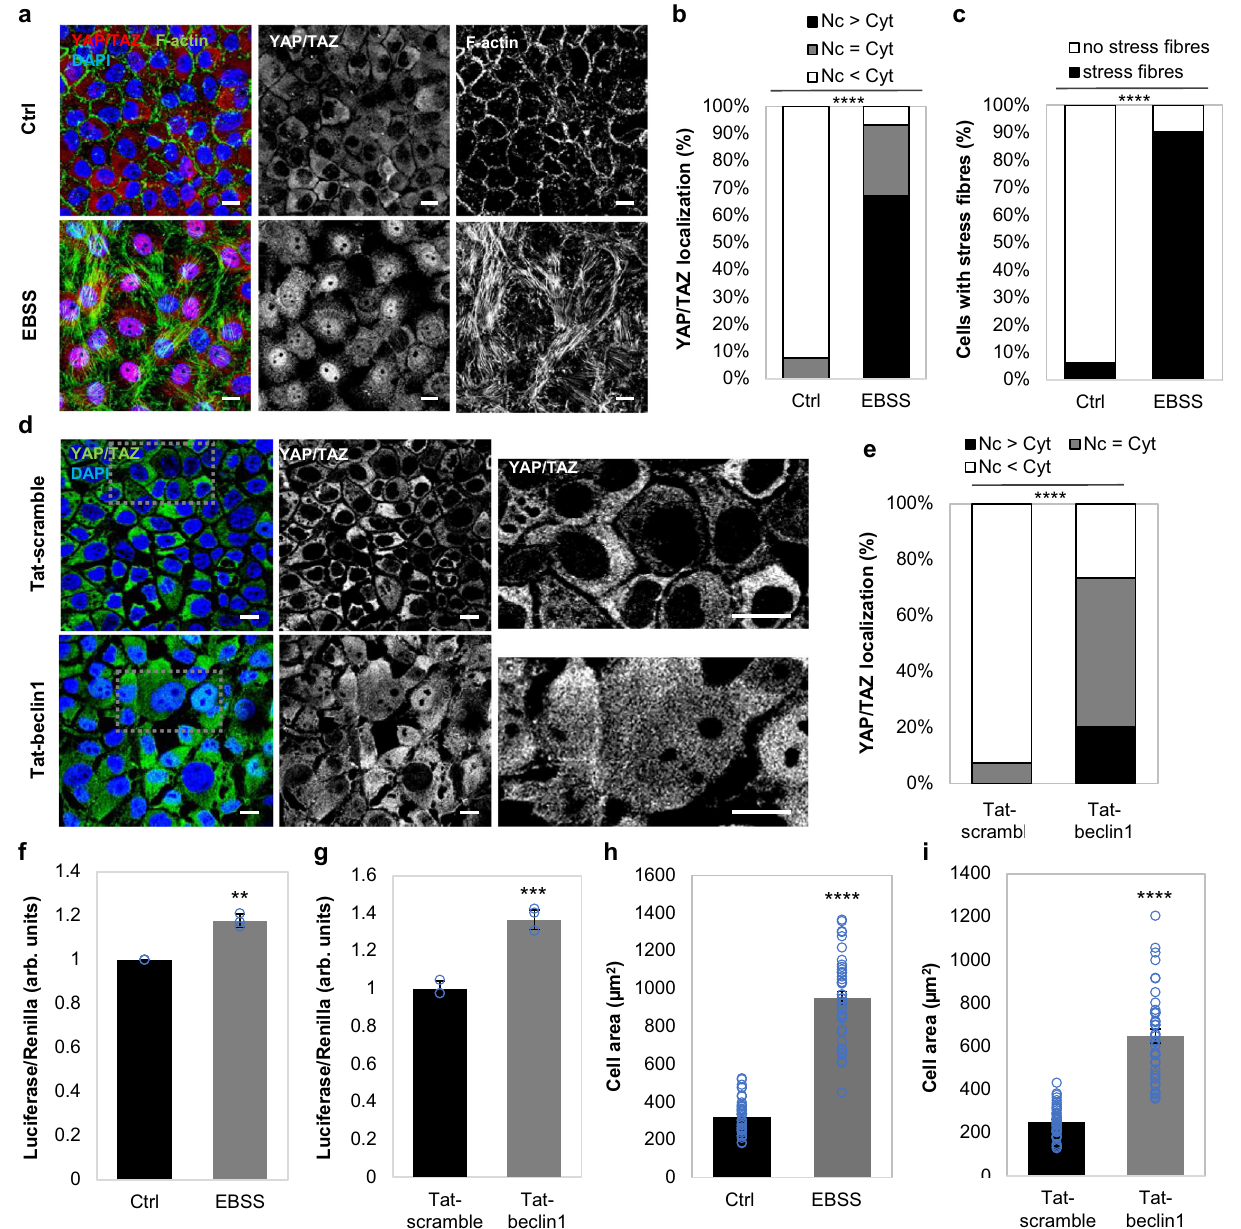
Fig. 3 YAP/TAZ is activated upon autophagy induction (EBSS, Tat-beclin1) in MCF10A cells. a Representative confocal images of YAP/TAZ and F-actin (phalloidin) immunostaining in MCF10A cells cultured at high con fl uency in EBSS for 6 h. Scale bars are 10 µ m. The experiment was repeated twice with similar results. b YAP/TAZ localisation in MCF10A cells exposed to EBSS for 6 h ( n = 143 cells (Ctrl), n = 146 cells (EBSS); **** P < 0.0001; chi-squared test). The experiment was repeated twice with similar results. c Percentage of MCF10A cells with stress fi bres upon starvation (EBSS, 6 h) ( n = 143 cells (Ctrl), n = 146 cells (EBSS); **** P < 0.0001; chi-squared test). The experiment was repeated twice with similar results. d Representative confocal images of YAP/TAZ immunostaining in MCF10A cells cultured at high con fl uency and exposed to either Tat-scramble (control) or Tat-beclin1 peptide (20 µ M, 48 h). Scale bars are 10 µ m. The experiment was repeated twice with similar results. e YAP/TAZ localisation in MCF10A cells exposed to either Tat-scramble (control) or Tat-beclin1 peptide (20 µ M, 48 h) (**** P < 0.0001; chi-squared test). The experiment was repeated with similar results. f TEAD luciferase activity in MCF10A cells starved with EBSS for 6 h. Bars represent the mean ± s.d. ( n = 3 independent experiments; ** P < 0.01; two-tailed one sample t -test). g TEAD luciferase activity in MCF10A cells treated with Tat-beclin1 peptide (20 µ M, 48 h). Bars represent the mean ± s.d. of a representative experiment performed in triplicates ( * ** P < 0.001; two-tailed t -test). h Size of MCF10A cells starved in EBSS. Bars represent the mean ± s.e.m. ( n = 42